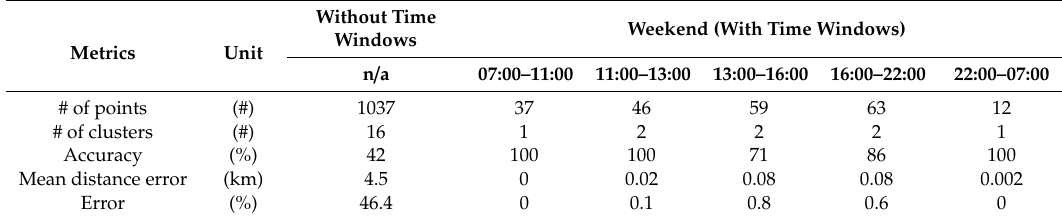
Table 5. Destination prediction results for the